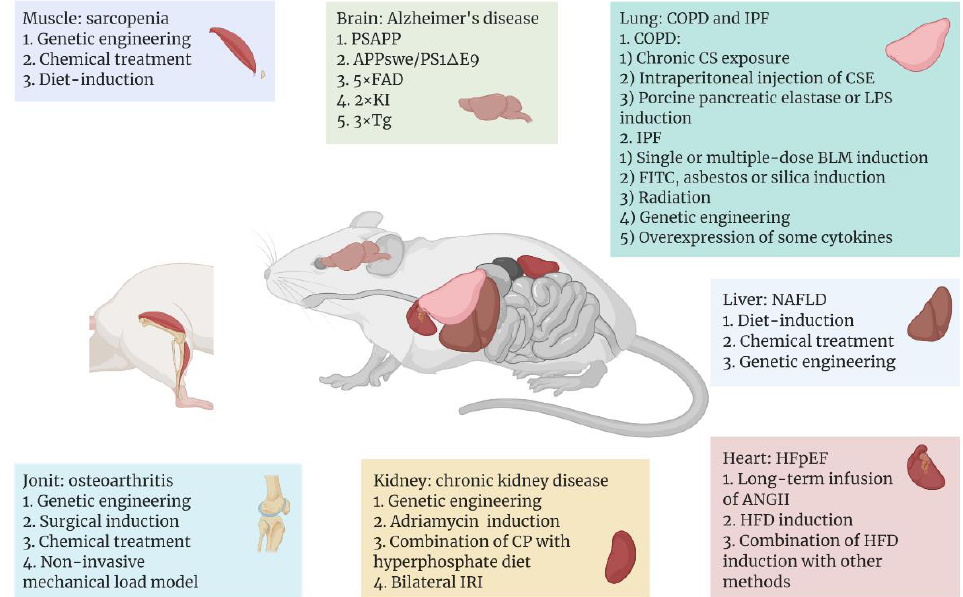
Figure 1. Aging-related diseases include Alzheimer’s disease (AD), sarcopenia, heart failure with preserved ejection fraction (HFpEF), non-alcoholic fatty liver disease (NAFLD), chronic kidney disease (CKD), osteoarthritis, chronic obstructive pulmonary disease (COPD), and idiopathic pulmonary fibrosis (IPF), which occur in different tissues or organs. With the help of mice as model organisms, researchers have used different methods to establish disease models in different tissues or organs of mice. In recent years, some common or emerging methods of modeling aging-related diseases are shown above, and these methods are classified according to the organ to which the disease mainly affects. Figure 1 was created with BioRender software (https://biorender.com/ (accessed on 20 April 2022)).